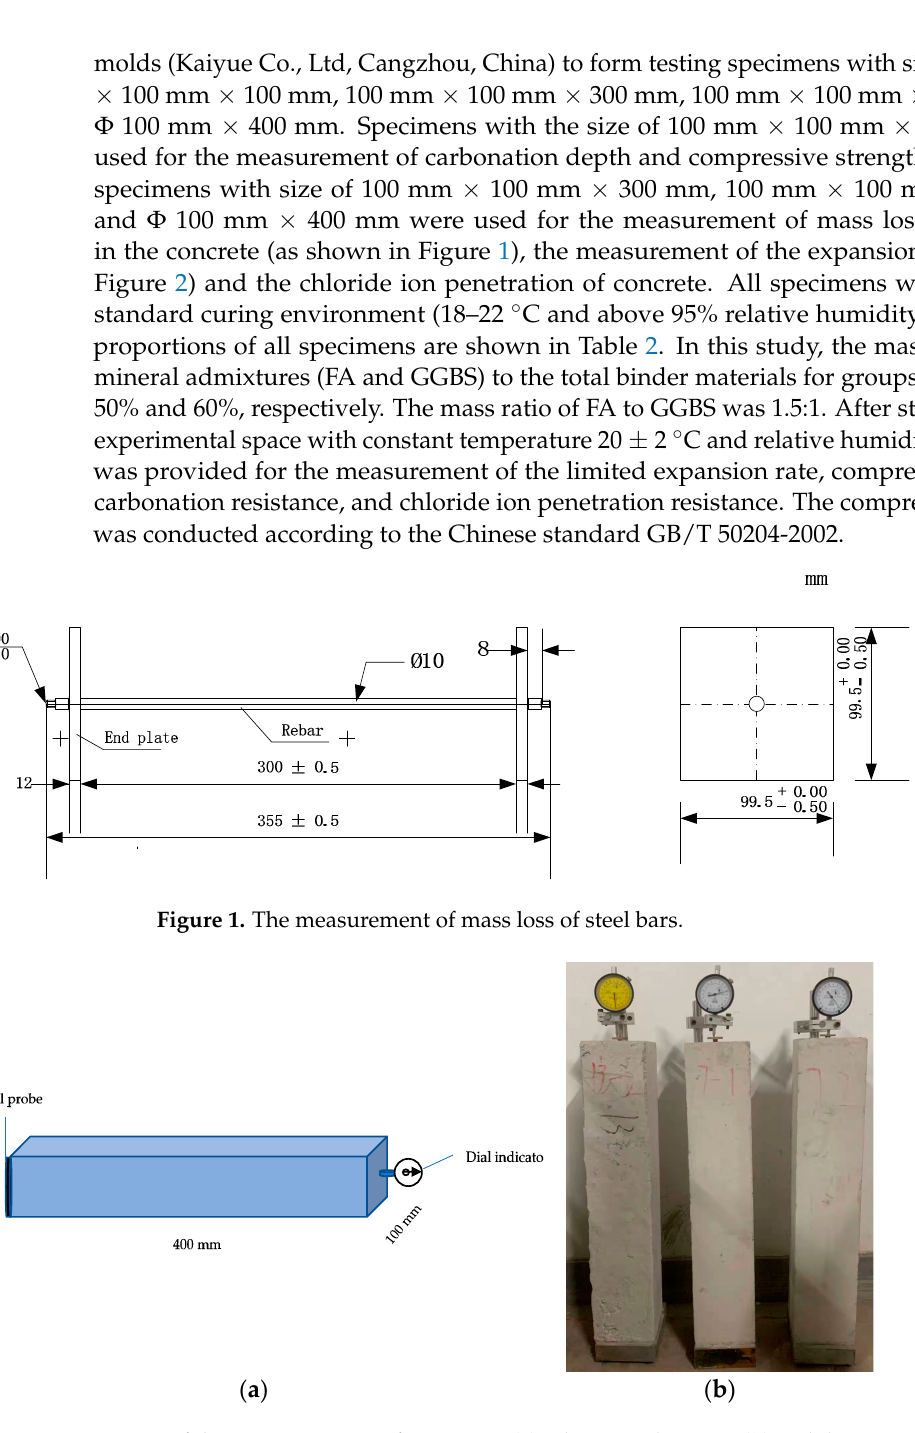
Figure 2. Measurement of the expansion rate of specimen, ( a ) schematic diagram, ( b ) real diagram. Table 2. The mix ratio of concrete with water–binder ratios of 0.33 and 0.43 (kg/m 3 ). The shrinkage rod of the dial indicator (Kaiyue Co., Ltd, Cangzhou, China) supports the middle of one end of the rectangular specimen. When the length of the specimen Samples changes, the dial indicator reads out the value of the length change. Through this method, the expansion value was measured. When the carbonation experiment was carried out, each specimen was cured for 28 days and then placed in type CCB-70F automatic concrete carbonation test box produced by Tianjin Deste Instrument Technology Co., Ltd (Tianjing, China), with 20% CO 2 by mass ratio of the total mass of gas for 30 days and 60 days, respectively. After curing, all specimens were dried in a vacuum drying oven (Shanghai Yi Heng Instrument Co., LTD DZF-6020, Shanghai, China) at 60 ◦ C for 48 h. When